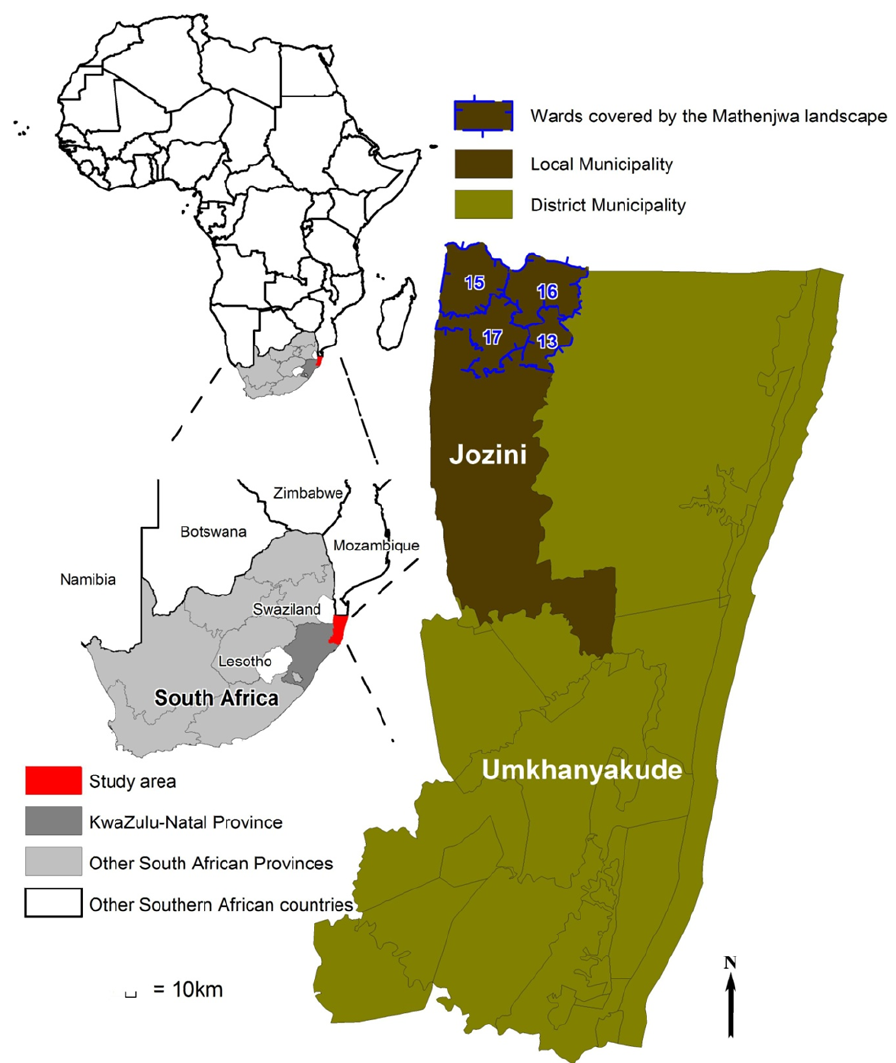
Figure 1. Location of the KwaZulu-Natal (KZN) site (Mathenjwa landscape) within South Africa’s administrative